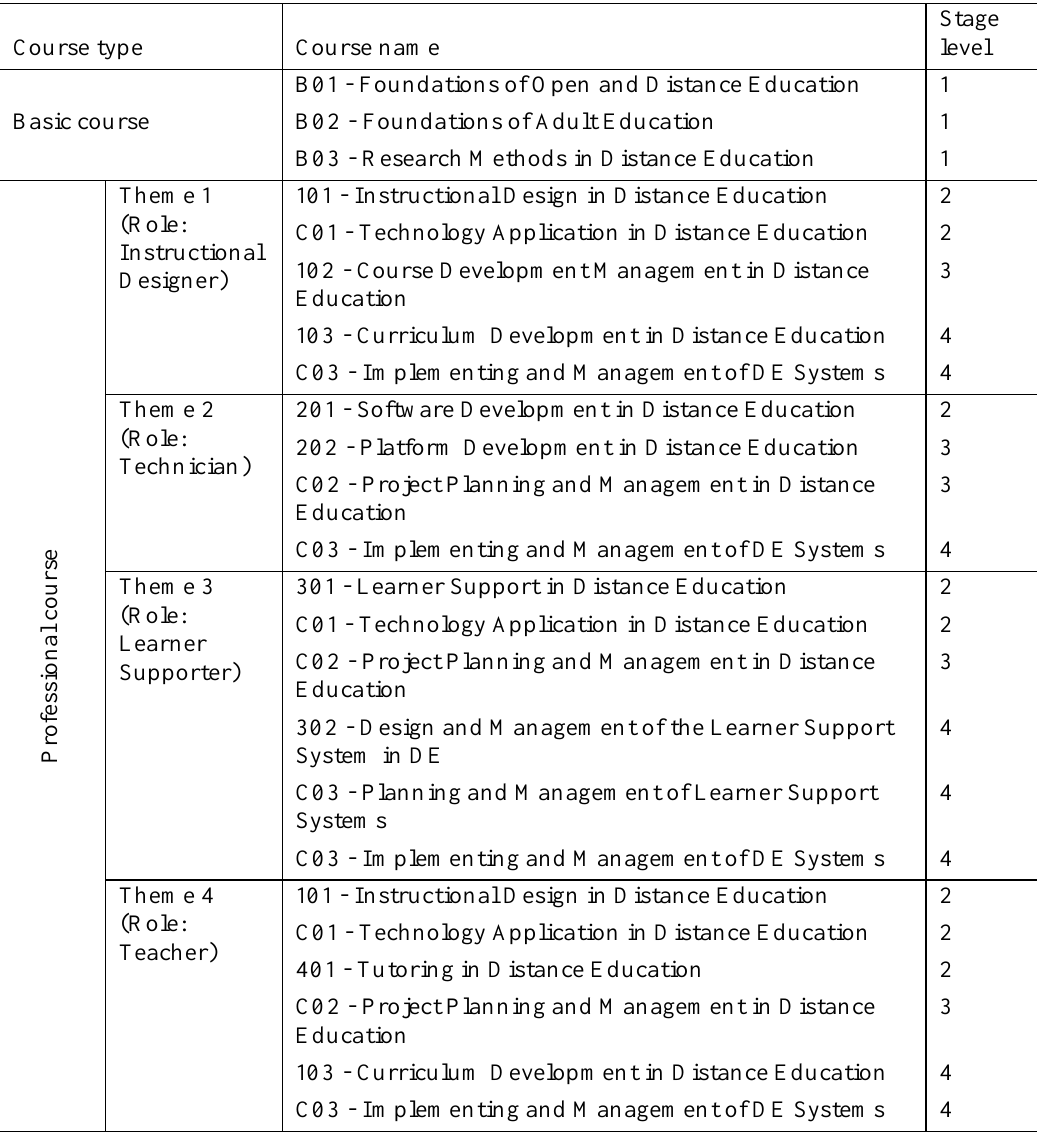
Table 4 The MDDE